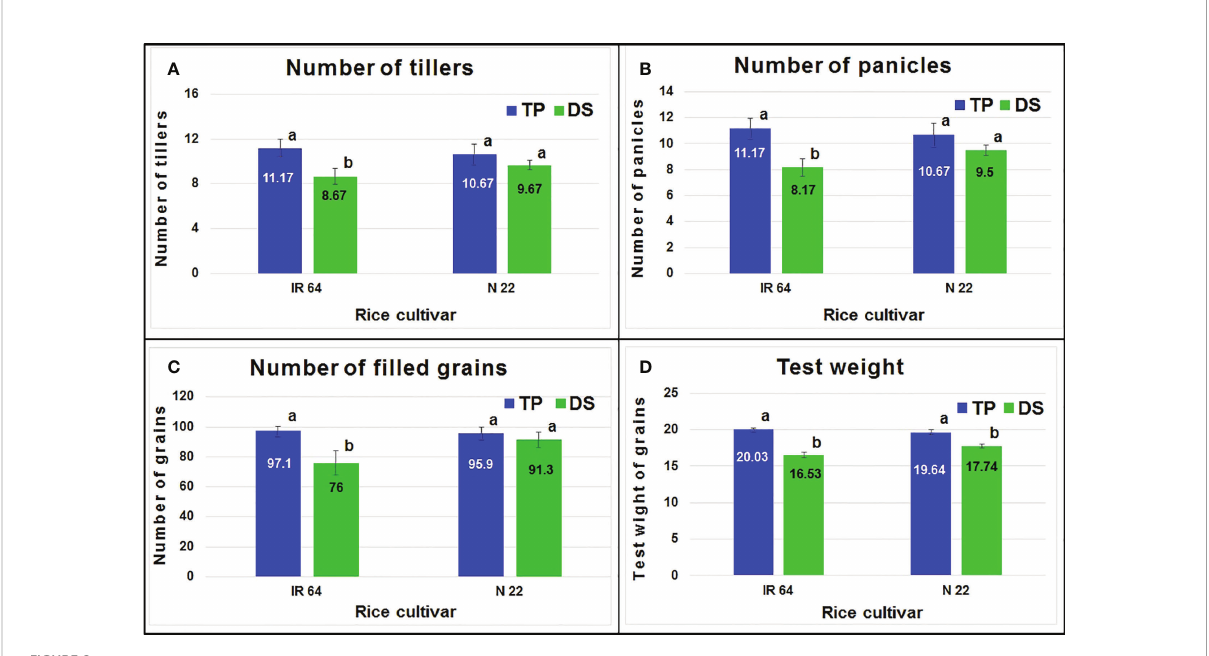
FIGURE 2 Agronomic performance of rice grown by different methods of planting. (A) Number of tillers per plant, (B) number of panicles per plant, (C) number of fi lled grains per panicle, (D) test-weight (g) of (1000) seeds. TP= transplanted, DS= direct-sown. Data present mean value (n=3). Mean followed by different lower-case letters are signi fi cantly different (P<0.05). The error bars represent the standard deviation ( ±